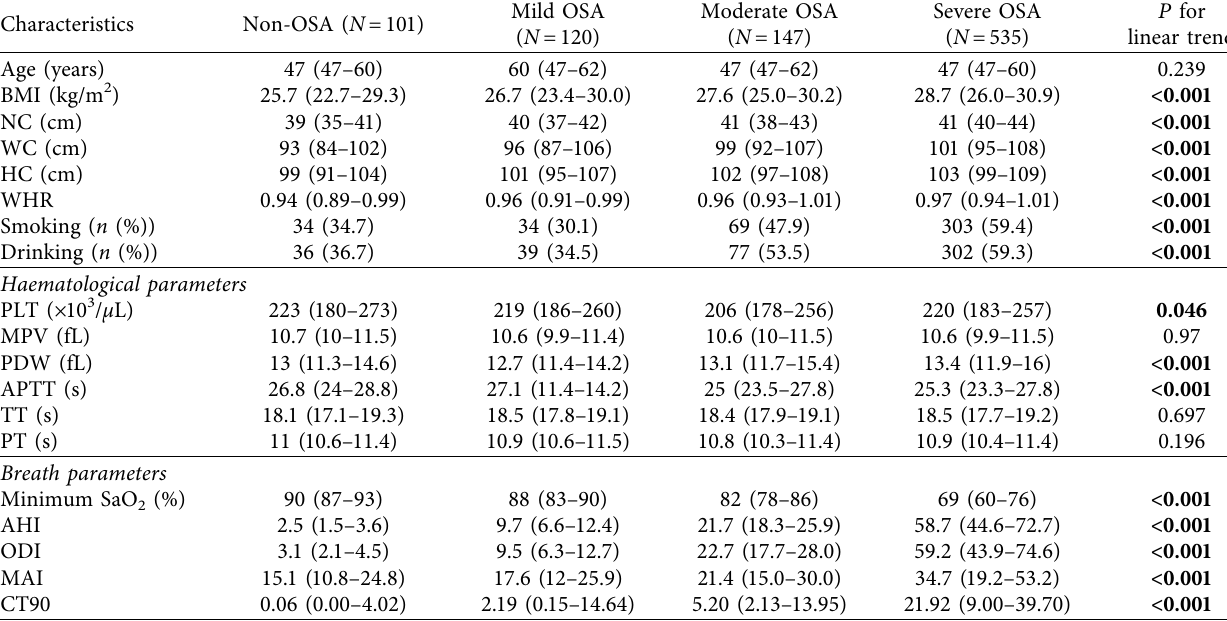
Table 1: Basic characteristics of the overall population by the severity of